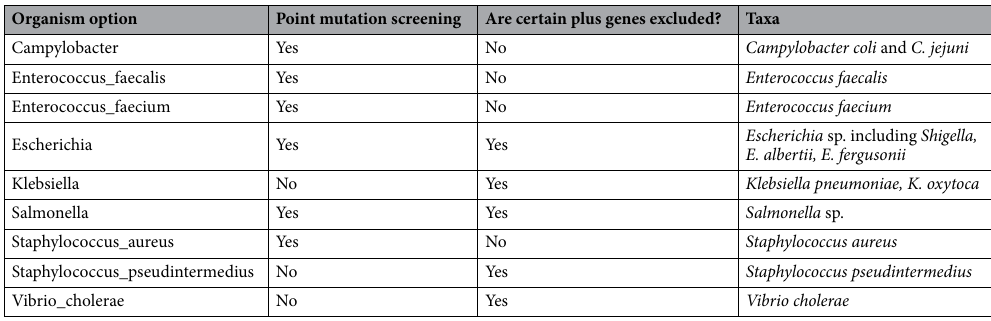
Table 2. Taxa for which genetic elements can be excluded or included. Organism option describes the value used by the --organism flag. Taxa describes the species referred to by that